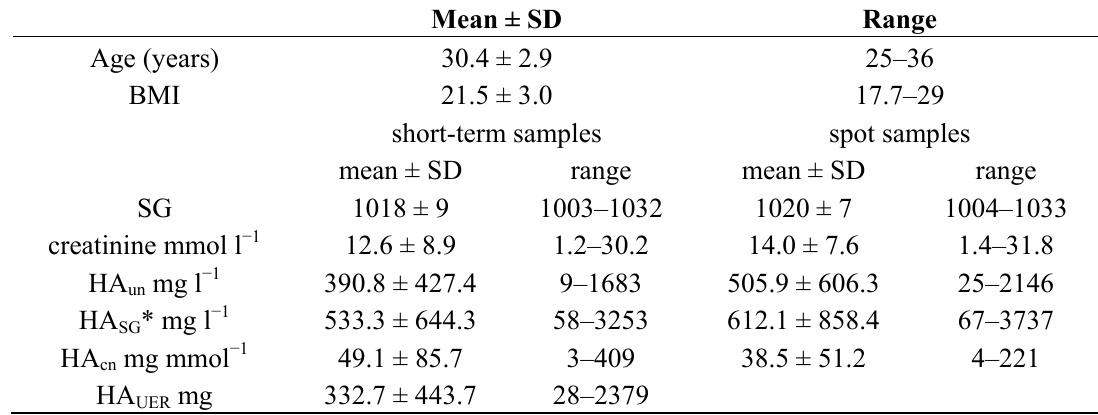
Table 1. Characteristics of the subjects and their urine and HA excretion in short-term and spot